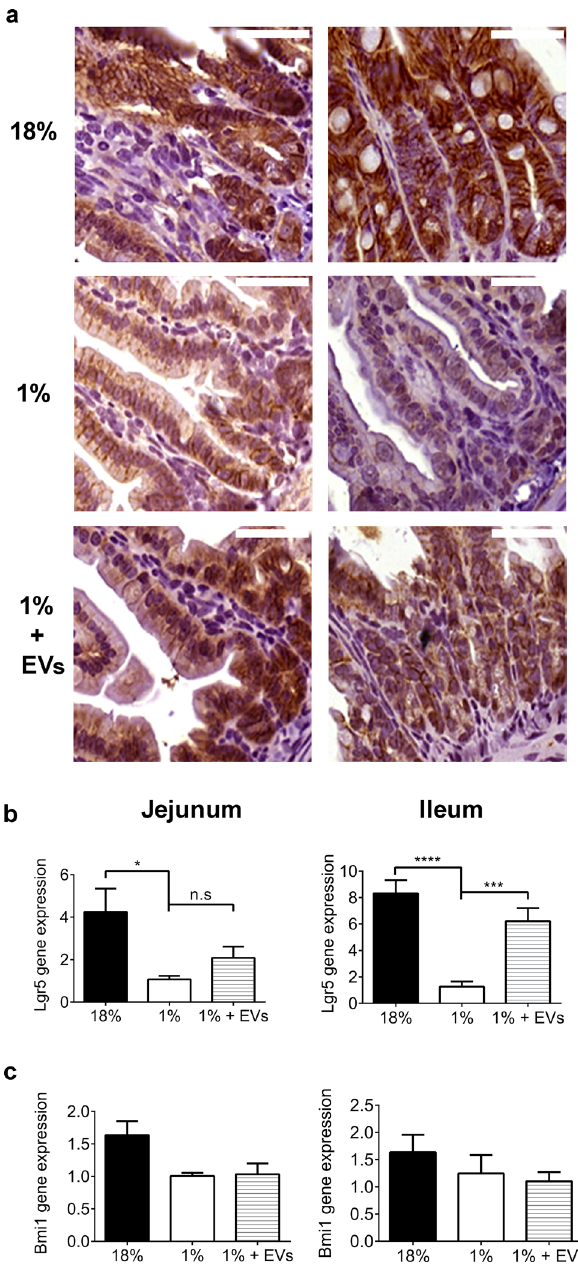
Figure 6. Milk EVs activate Wnt pathway, as seen by increased β-catenin staining, and intestinal epithelial stem cell proliferation, as seen by increased Lgr5 + cells. Stem cell activation in: controls, i.e. sham-treated mice fed 18% protein diet; sham-treated mice fed 1% protein diet; and milk EV-treated mice fed 1% protein diet, represented by: Immunohistochemistry of ( a ) Jejunum and ileum staining for β-catenin, 63 × magnification, n = 3/group. Scale bar, 40 µm; ( b ) qPCR analysis of Lgr5 expression relative to Ribosomal protein L13A ( Rpl13a ) in Jejunum and Ileum (**** P < 0.0001, *** P < 0.001, n = 6/group). ( c ) qPCR analysis of Bmi1 in jejunum and ileum relative to Rpl13a (n = 6/group). Each column represents mean ± standard error of mean (SEM). Graphs and statistical tests were done using GraphPad Prism version 6.0.0 for Windows (www. graph pad.